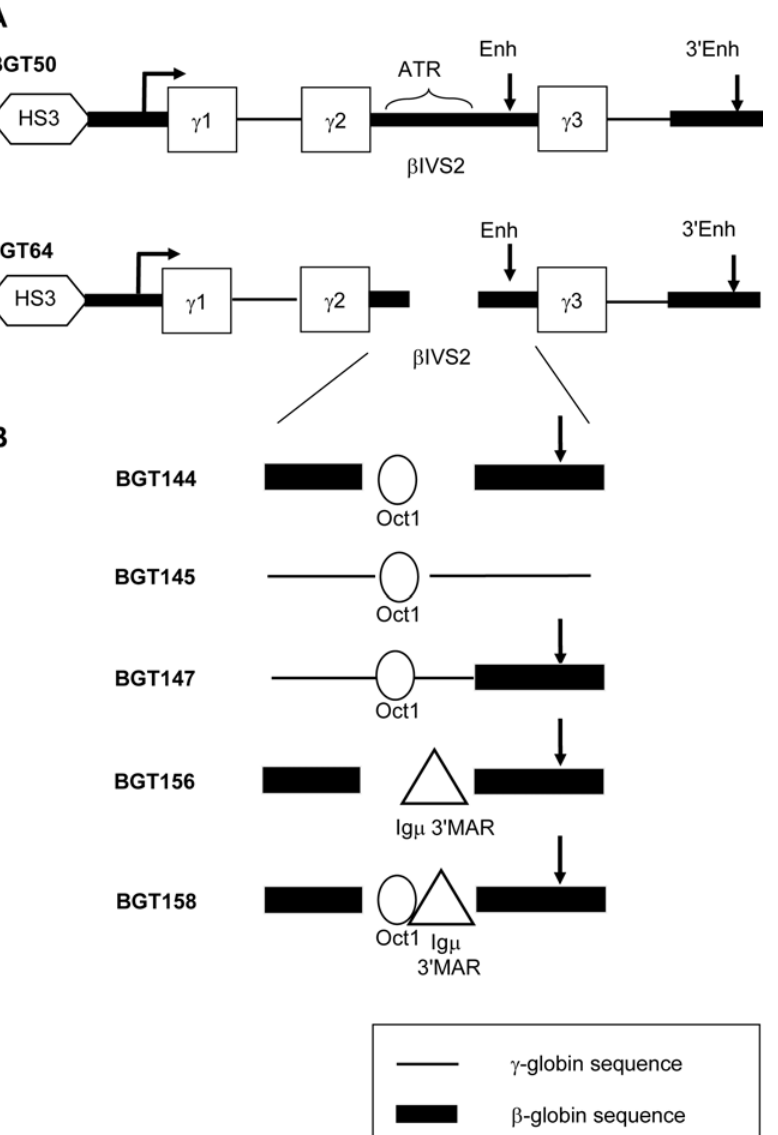
Figure 1. Maps of LCR b / c -globin transgene constructs with intronic insertions of a consensus Oct-1 site or the Ig m 3 9 MAR element. (A) The BGT50 cassette is comprised of 5 9 HS3, b -globin promoter, A c -globin exons 1-3, b -globin intron 2 ( b IVS2) containing the AT-rich region (ATR) and intronic enhancer, and the 3 9 b -globin enhancer. The BGT64 cassette contains the 372 bp ATR deletion. (B) Intronic modifications generated in the LCR b / c -globin transgenes. BGT144 contains an Oct-1 site in place of the deleted ATR along with the intronic enhancer. BGT145 has an Oct-1 site in the A c -globin intron 2. BGT147 contains the Oct-1 site and intronic enhancer in a hybrid intron with 5 9 A c -globin and 3 9 b -globin sequences. BGT156 contains the Ig m 3 9 MAR in place of the deleted ATR along with the intronic enhancer. BGT158 contains the Oct-1 site 5 9 of the Ig m 3 9 MAR in place of the deleted ATR and the intronic enhancer.